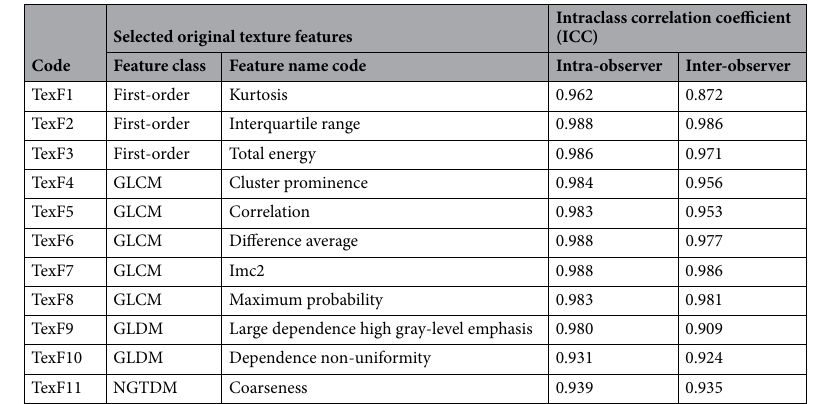
Table 1. Selected original texture features for machine learning–based classifications of IIM and non-IIM disease groups. GLCM gray-level co-occurrence matrix, GLDM gray-level dependence matrix, NGTDM neighboring gray-tone difference matrix.